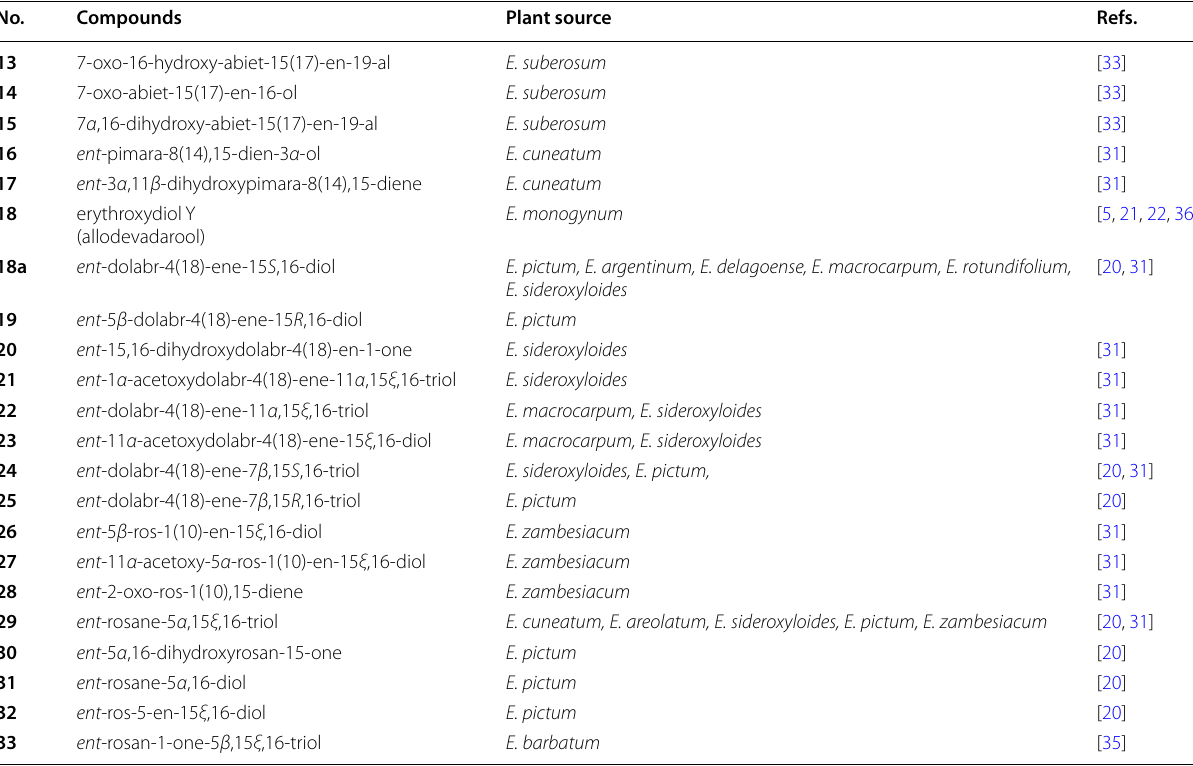
Table 3 Tricyclic diterpenes isolated from Erythroxylum plants No. Compounds Plant source Refs.